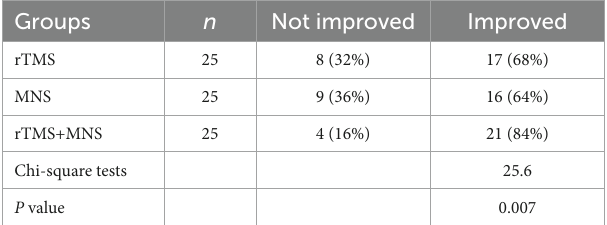
TABLE 3 Comparison of electroencephalogram (EEG) activity improvement among the three groups of